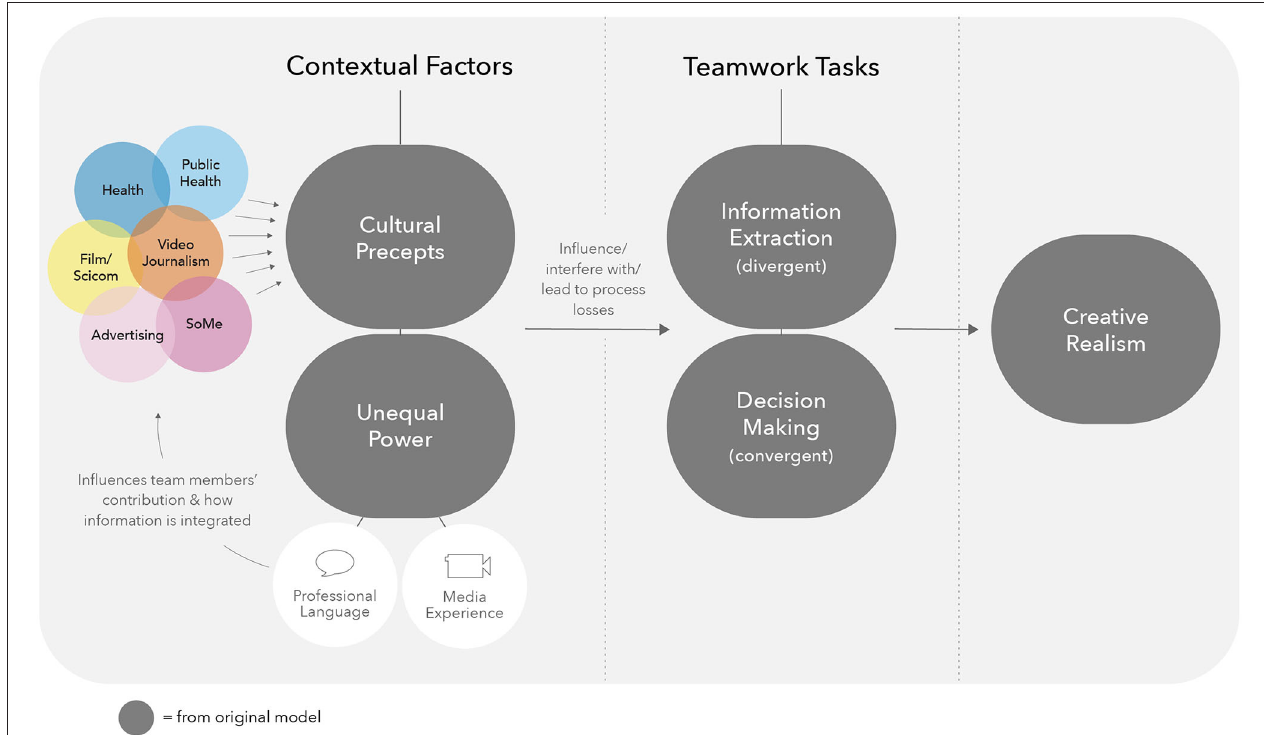
FIGURE 9 | Graphic interpretation of Janssens and Brett’s (2006) fusion model of global team collaboration showing factors influencing creative realism in global teams, modified for interdisciplinary team